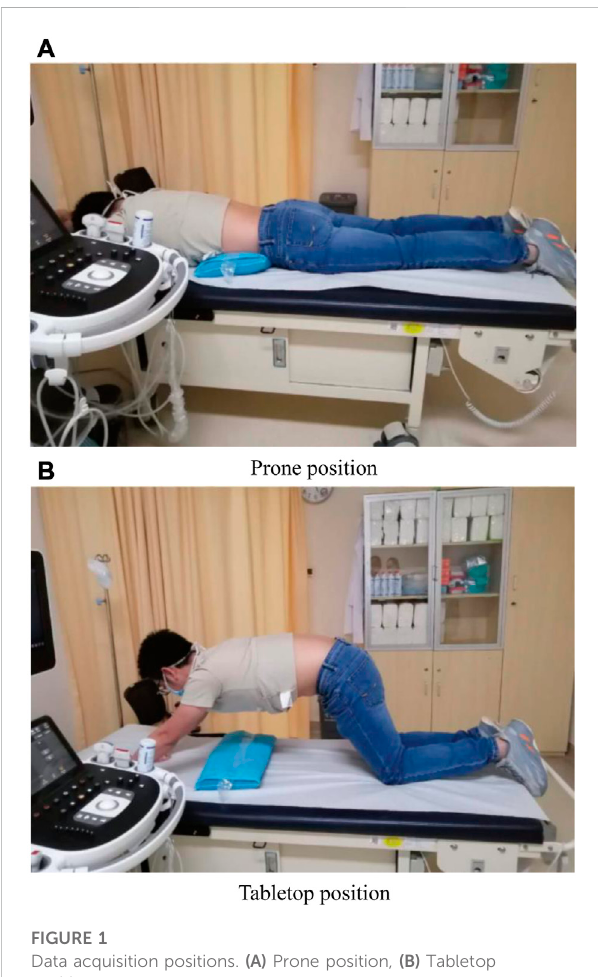
FIGURE 1 Data acquisition positions. (A) Prone position, (B) Tabletop